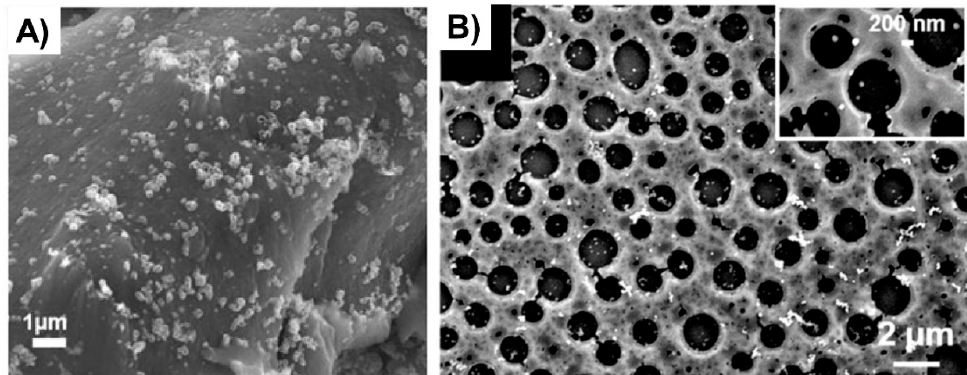
Figure 5. ( A ) Ag NPs supported on a powder-like PS. [51], Copyright 2019. Reproduced with permission from Wiley-VCH Publishers; and ( B ) Au NPs supported on a porous PS film. [55], Copyright 2017. Reproduced with permission from the American Chemical Society.